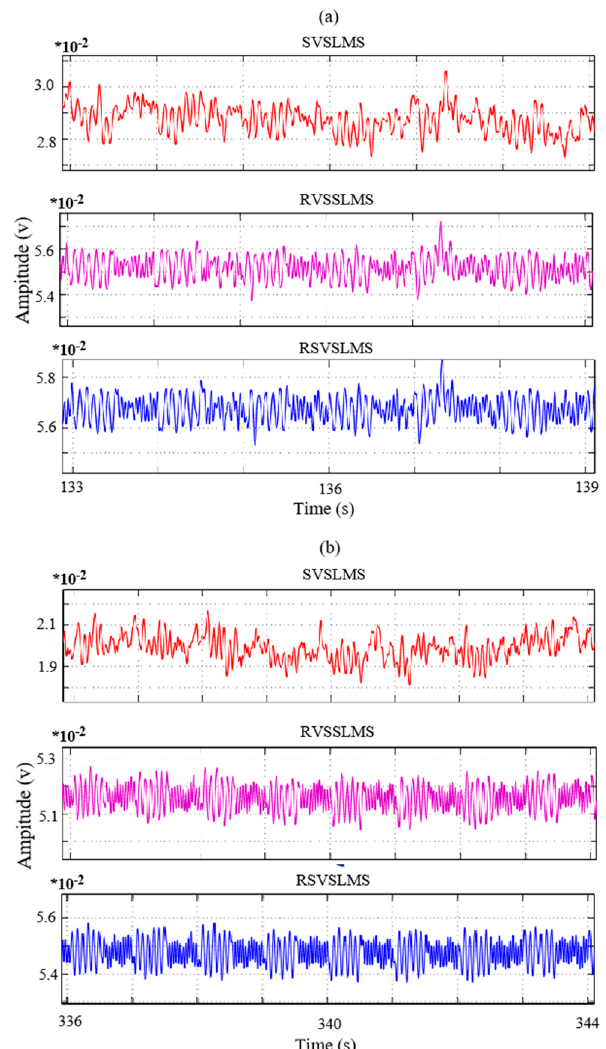
Figure 16. Comparison of pseudo-synthetic telemetry processing results for time range: ( a ) 133 to 139 s, and ( b ) 336 to 344 s. The results were obtained by using multi-channel noise cancellation techniques. Top: Sigmoid variable step-size LMS (SVSLMS). Middle: Regularized variable step-size LMS (RVSSLMS). Below: Regularized sigmoid variable step-size LMS (RSVSLMS).